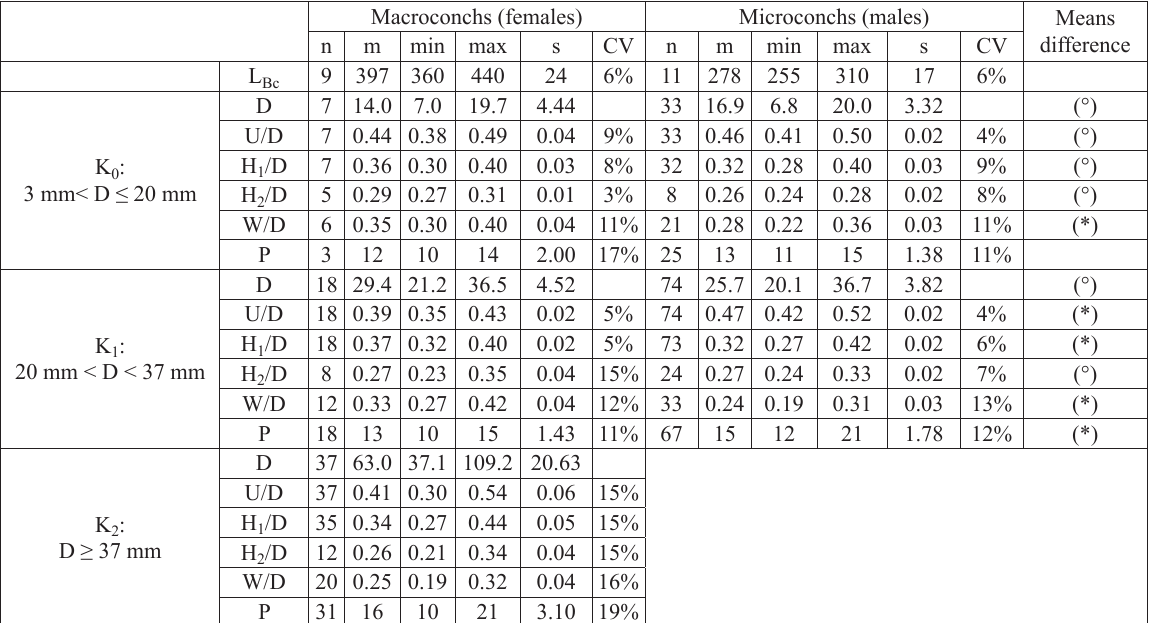
Table 1. Statistical parameters and comparison of relative morphology: length of body chamber (in angular degrees), diameter (in mm), and rib density between dimorphs. Means difference, the statistical significance of the difference between the mean values: (°), non-significant, if probability > 0.05; (*) significant, if probability < 0.05. The comparison of mean values of diameter is given only for indicating the homogenety of the positions of the subsamples of macro- and microconchs within the corresponding developmental stages. Abbreviations: CV = 100 s/m, percentual variation coefficient; m, arithmetic mean; n, sample size; s, standard deviation; D, diameter; H 1 /D, whorl height ratio; H 2 /D, ventral (or apertural) whorl height ratio; L Bc , length of body chamber; P, rib density, number of primary ribs per half-whorl; U/D, umbilical width ratio; W/D, whorl width